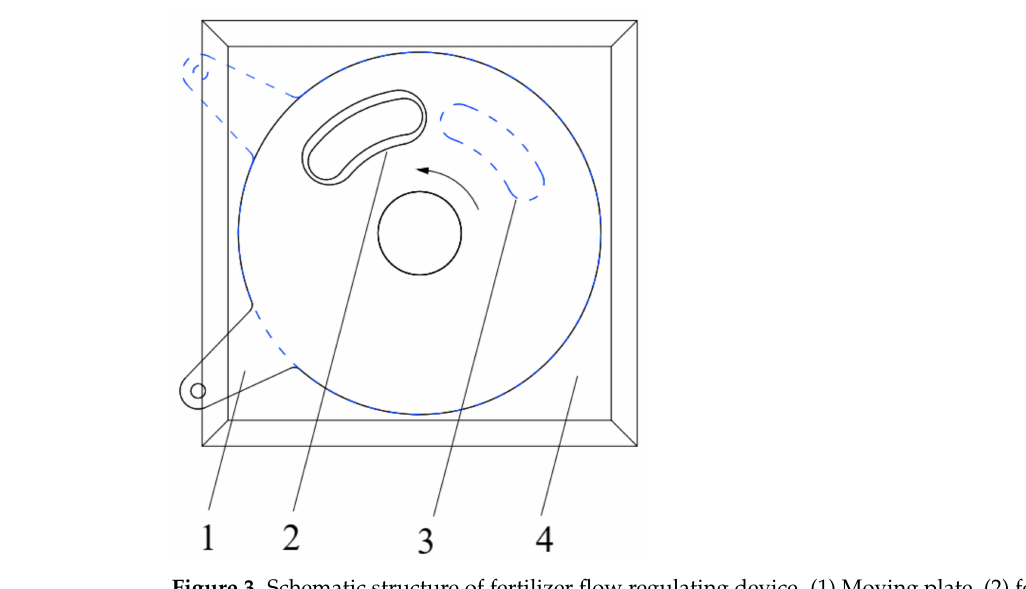
Figure 3. Schematic structure of fertilizer flow regulating device. (1) Moving plate, (2) feed gate hold in fixed plate, (3) feed gate hold in moving plate, and (4) fixed plate.